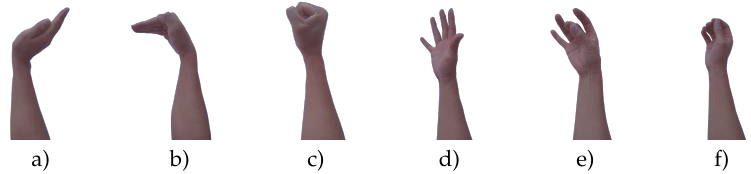
Figure 4. Hand gestures to be recognized for the proposed architecture. ( a ) waveOut, ( b ) waveIn, ( c ) fist, ( d ) open, ( e ) pinch, and ( f )